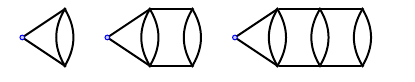
Figure 7 . The pure ladders U 1 ; U 2 and U 3 .